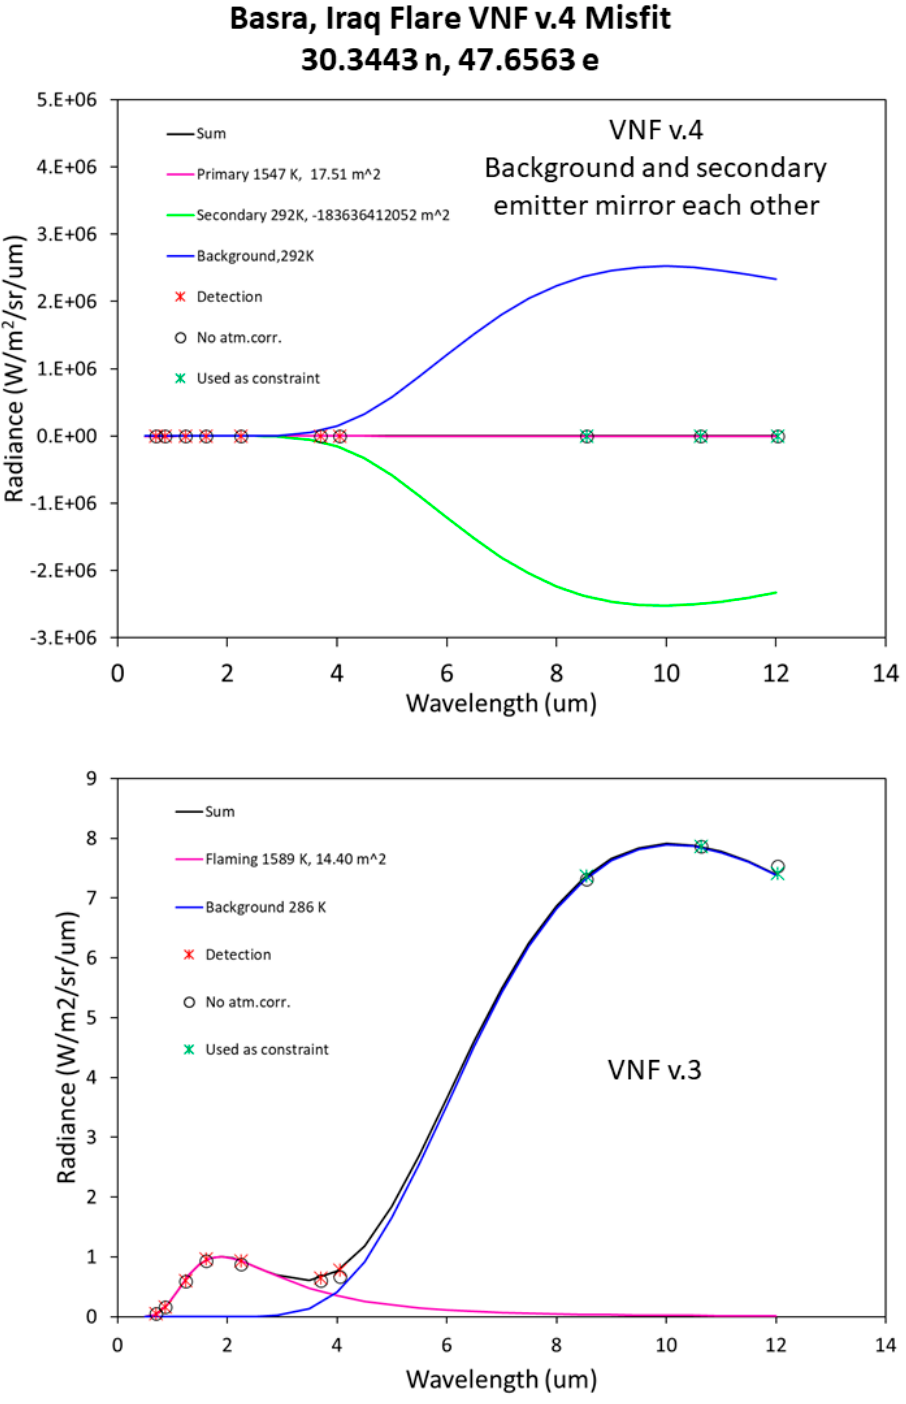
Figure 15. Spectral diagrams of a Type 4 misfit pixel from a Basra gas flare. The esf for secondary emitter is negative, resulting in negative radiances. The pixel moves from Type 4 to Type 5 with the VNF v.3 fit.